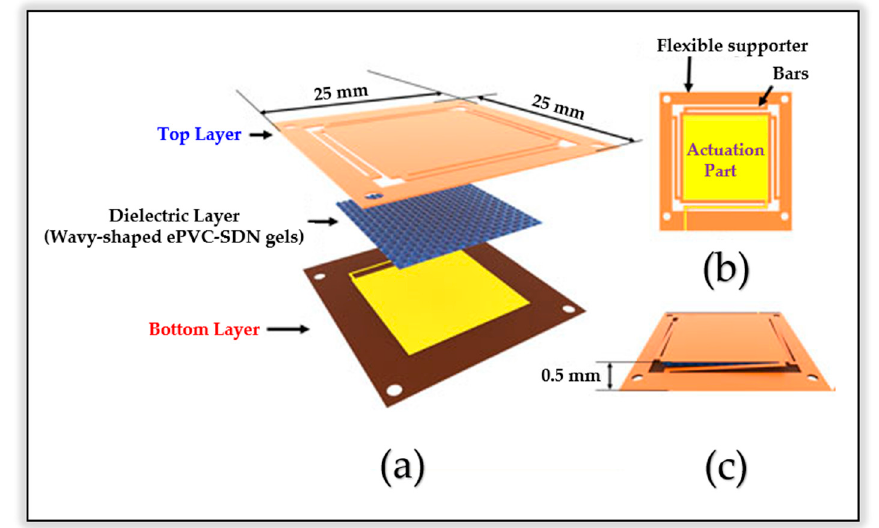
Figure 1. Illustrations representing the fabrication of the soft vibrotactile actuator based on ePVC–silicon dioxide nanoparticle (ePVC-SDN) gels. ( a ) Composition of the vibrotactile actuator. ( b ) Bottom surface of the upper layer. ( c ) Assembled vibrotactile actuator. Adapted with permission from [70], IEEE, 2018.